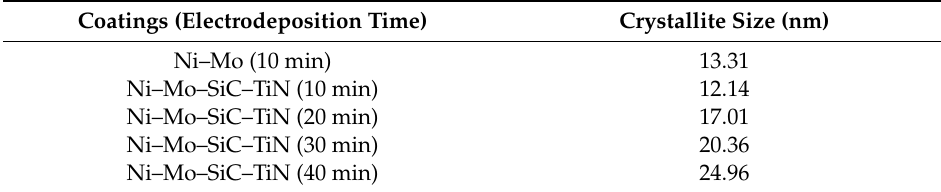
Table 2. Crystallite size of di ff erent coatings electrodeposited at 6.0 V.